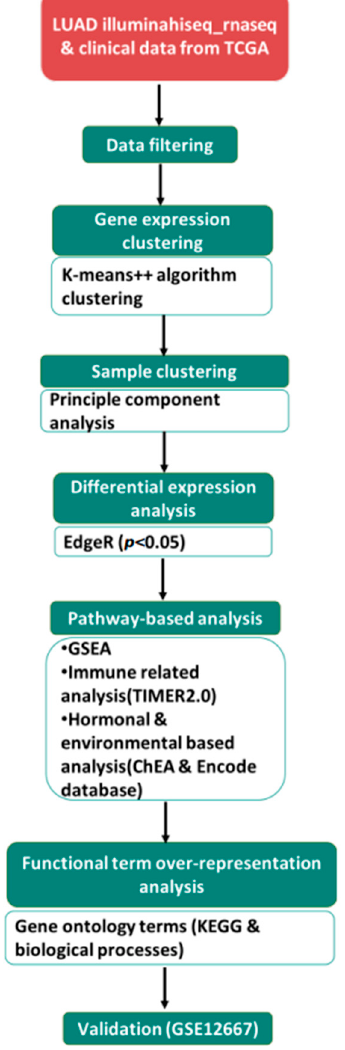
Figure 1. Flowchart of the data analysis process. illuminahiseq_rnaseq and patient clinical data were downloaded from TCGA. Following data filtering, partitioning modified K-means clustering algorithm was performed using ExpressCluster. Principal component analysis (PCA) using R was used to explore the 6 patient subgroups (FN, FC, FR, MN, MC and MR), assessing the variation across each category according to sex. EdgeR was used to explore differential expression, yielding 161 DEGs ( p < 0.05). Pathway analysis was also performed (refer to the methodology section for the detailed approach). Validation of DEGs was performed on GSE12667 probes.